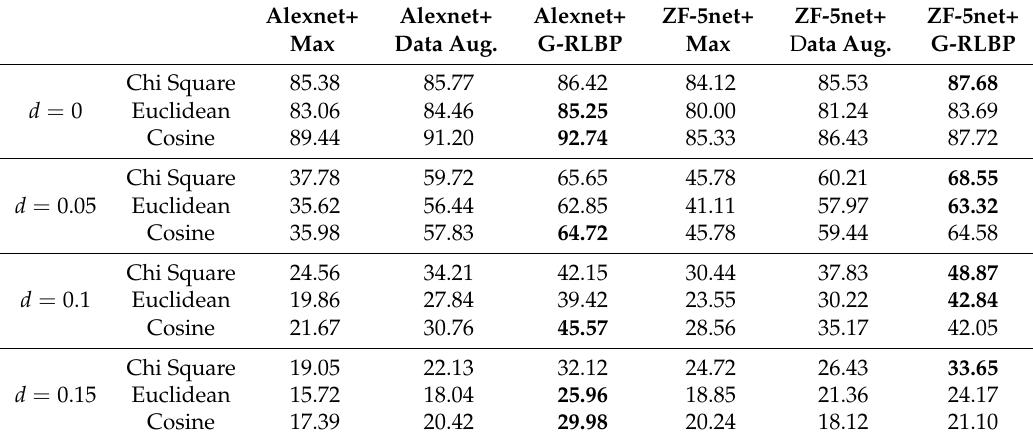
Table 4. The recognition rates (%) of different pooling methods and data augmentation based on the Alexnet and ZF-5net on the ORL database with different salt and pepper